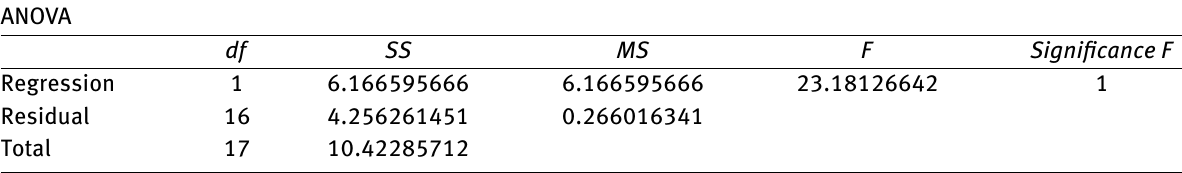
Table 6: Regression Statistics using ANOVA for Temperature Analysis